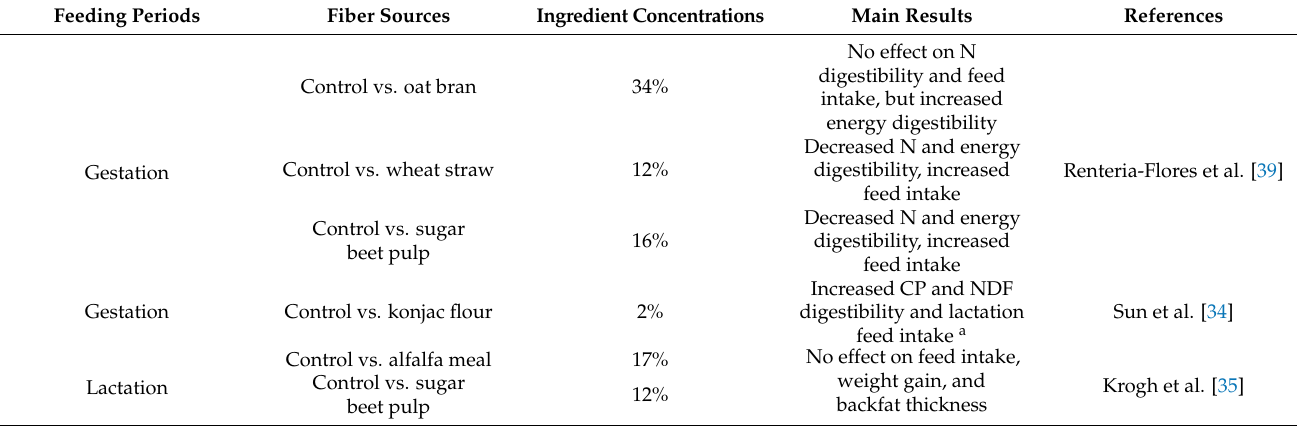
Table 4. Results of studies evaluating the effect of dietary fiber sources on feed intake, nutrient digestibility, and behaviors of